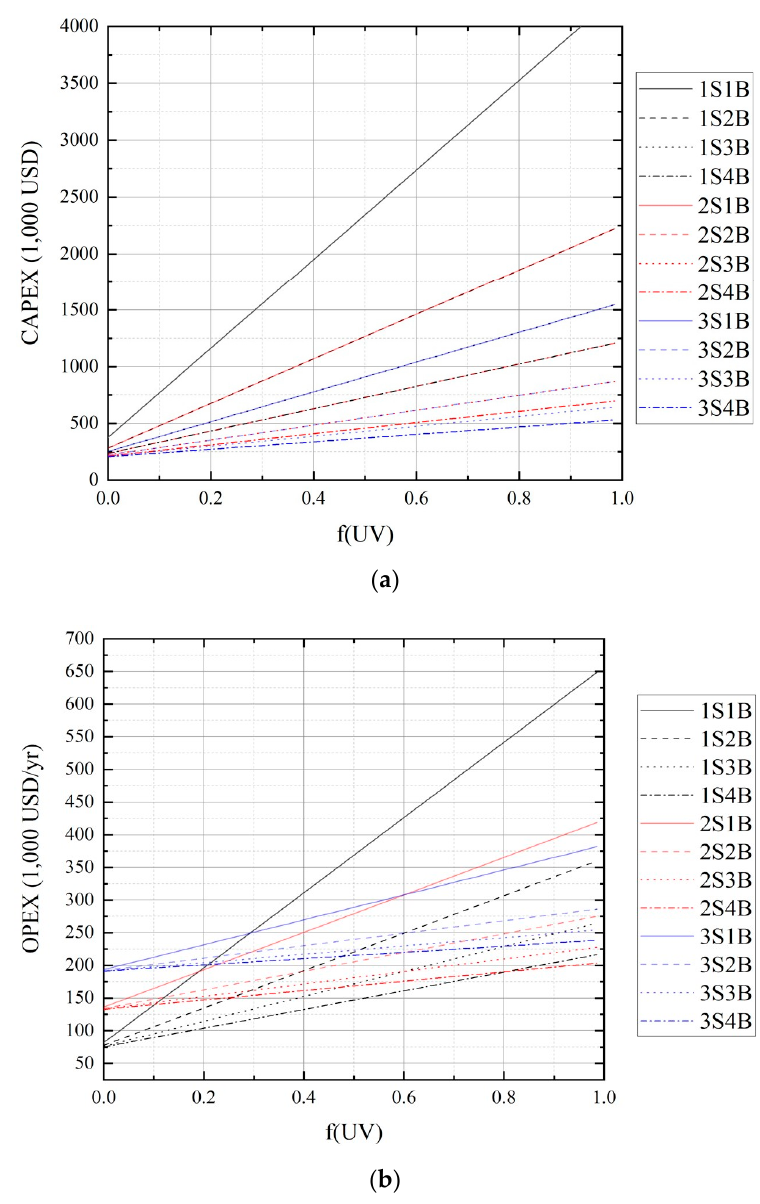
Figure 9. Impact of f(UV) on the ( a ) CAPEX and ( b ) OPEX for the three shift systems (1S, 2S, and 3S) with one to four operation batches (1B, 2B, 3B, and 4B) per shift. Table 3. Detailed Cost Estimation and Operation